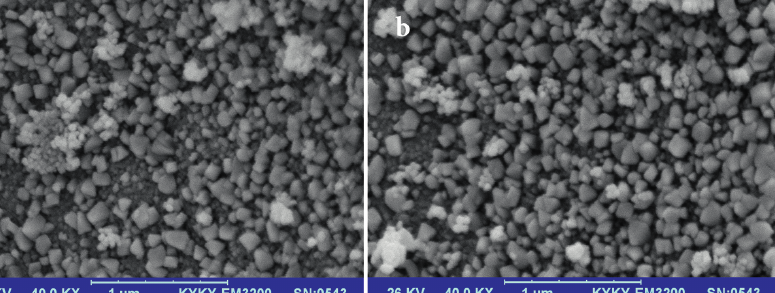
Figure 2: XRD pattern of FeAl 2 O 4 nanopowders.